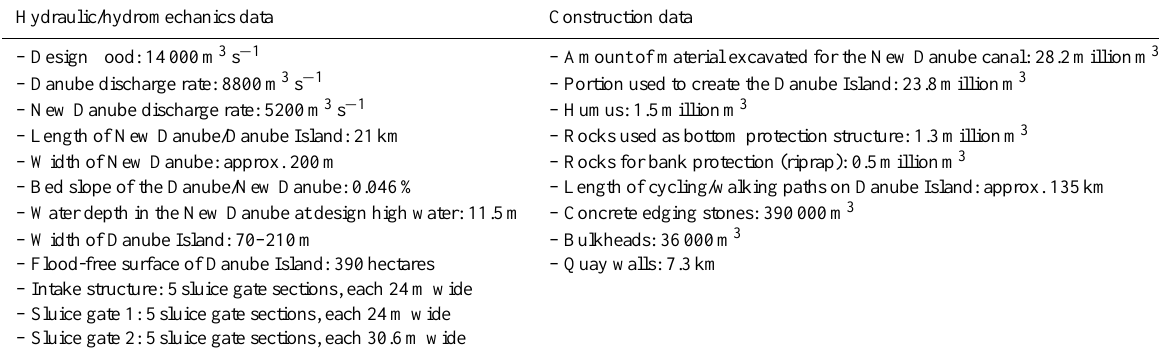
Table 2. Technical data about flood protection system in the city of